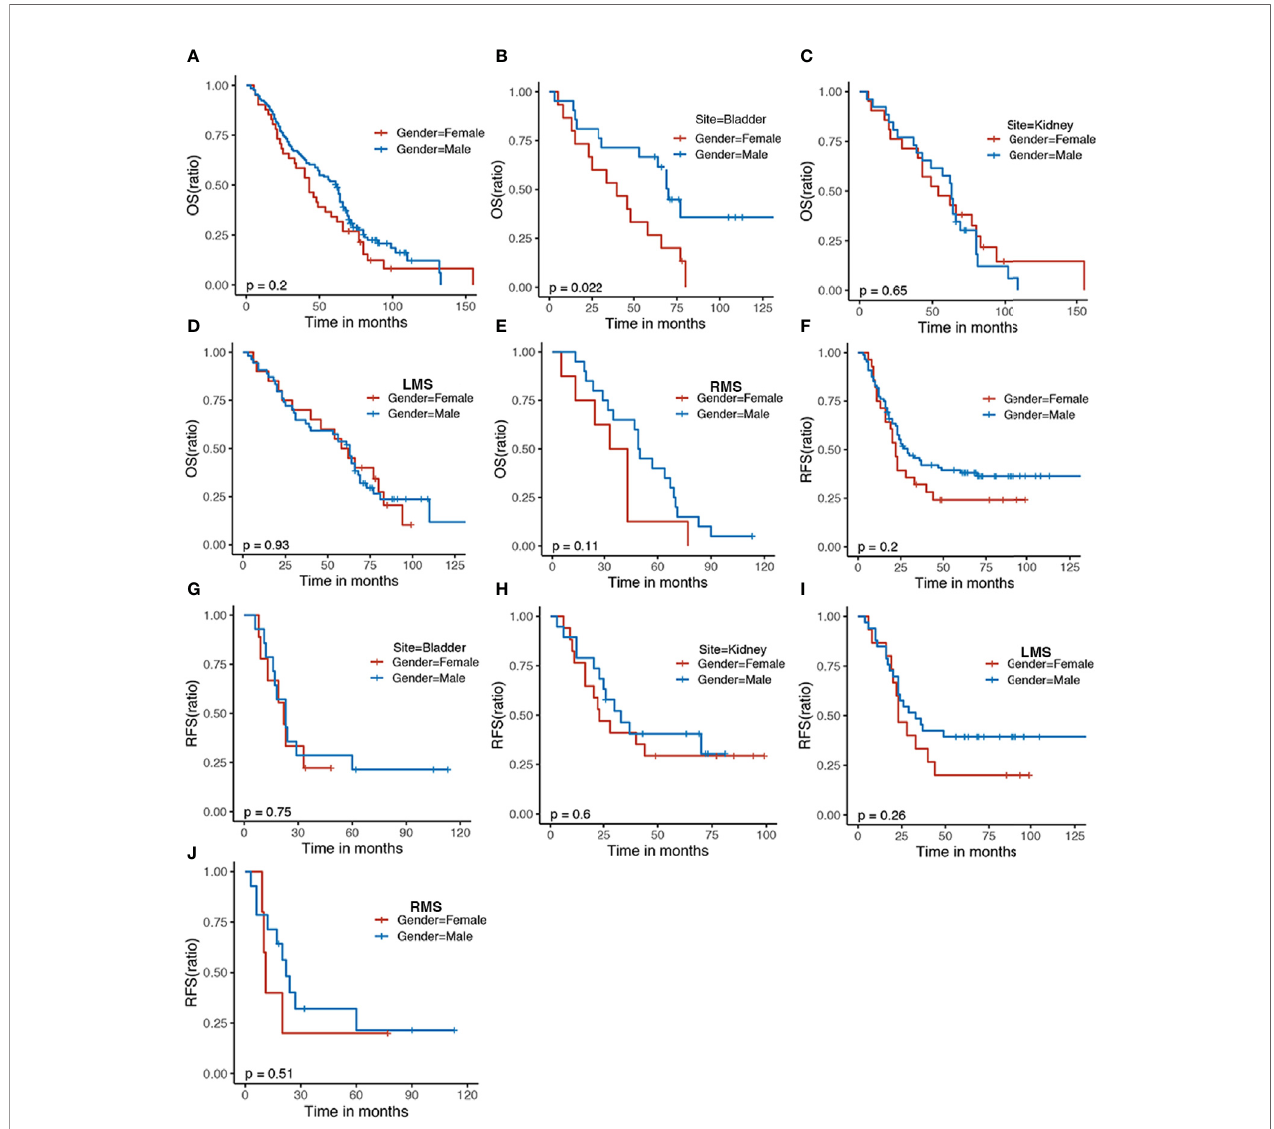
FIGURE 1 | The Kaplan – Meier survival curve comparing (A) OS and (F) RFS of the female and male patients with sarcoma. Kaplan – Meier survival estimating (B, C) OS and (G, H) RFS of bladder and kidney sarcoma strati fi ed by gender as well as histological subtypes including LMS (D, I) and RMS (E, J) . OS, overall survival; RFS, recurrence-free survival; LMS, leiomyosarcoma; RMS,